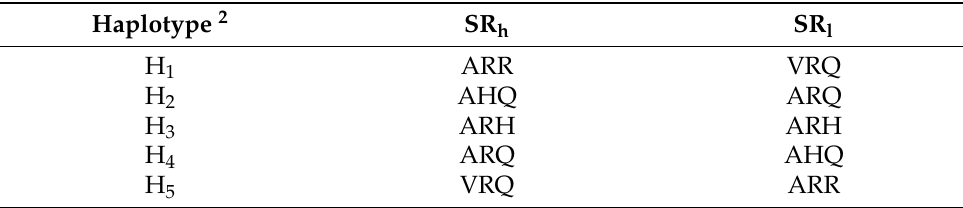
Table 3. Genotypes assigned to haplotypes for the scrapie resistance analyses 1 .